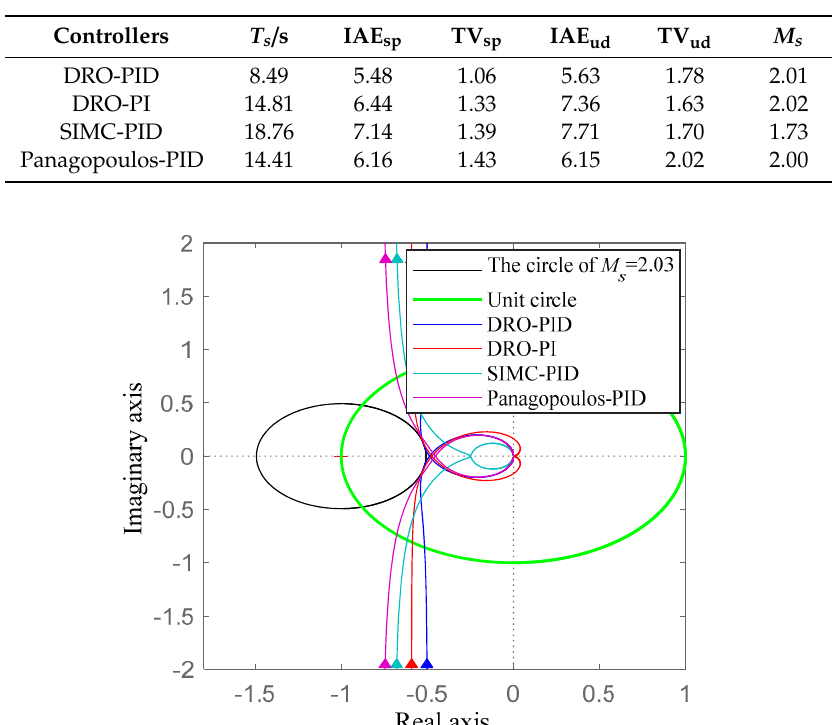
Figure 10. The control signal of the step set-point and input disturbance for Example 2. Table 6. The indices of Example 2 with different controllers.